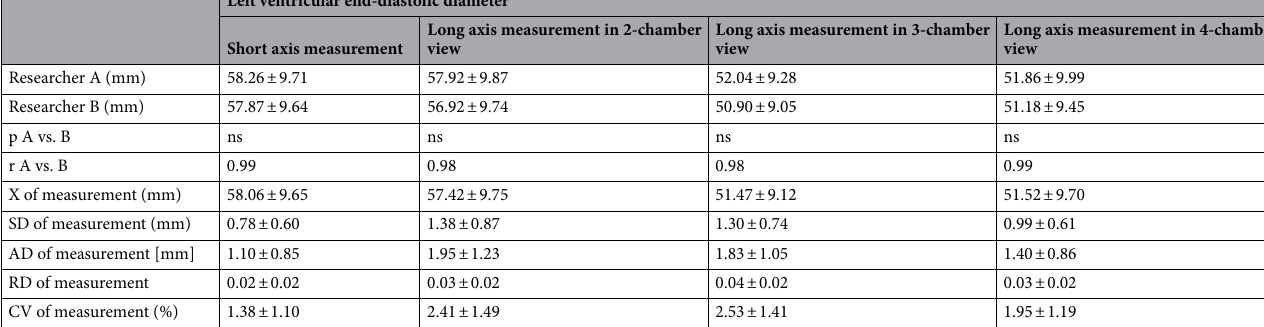
Table 2. Repeatability analysis of left ventricular end-diastolic diameter measurements in CMR (n = 78). Values are presented as mean ± standard deviation. AD absolute difference, CV coefficient of variation, ns non- statistically significant, p statistical significance coefficient, r correlation coefficient, RD relative difference, SD standard deviation, X arithmetic mean.